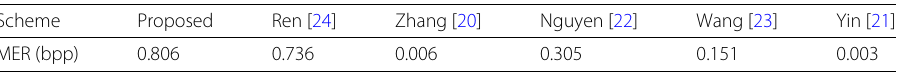
Table 4 Average maximum embedding rate (MER) for six RDH schemes by using the large-scale image database BOSSBase